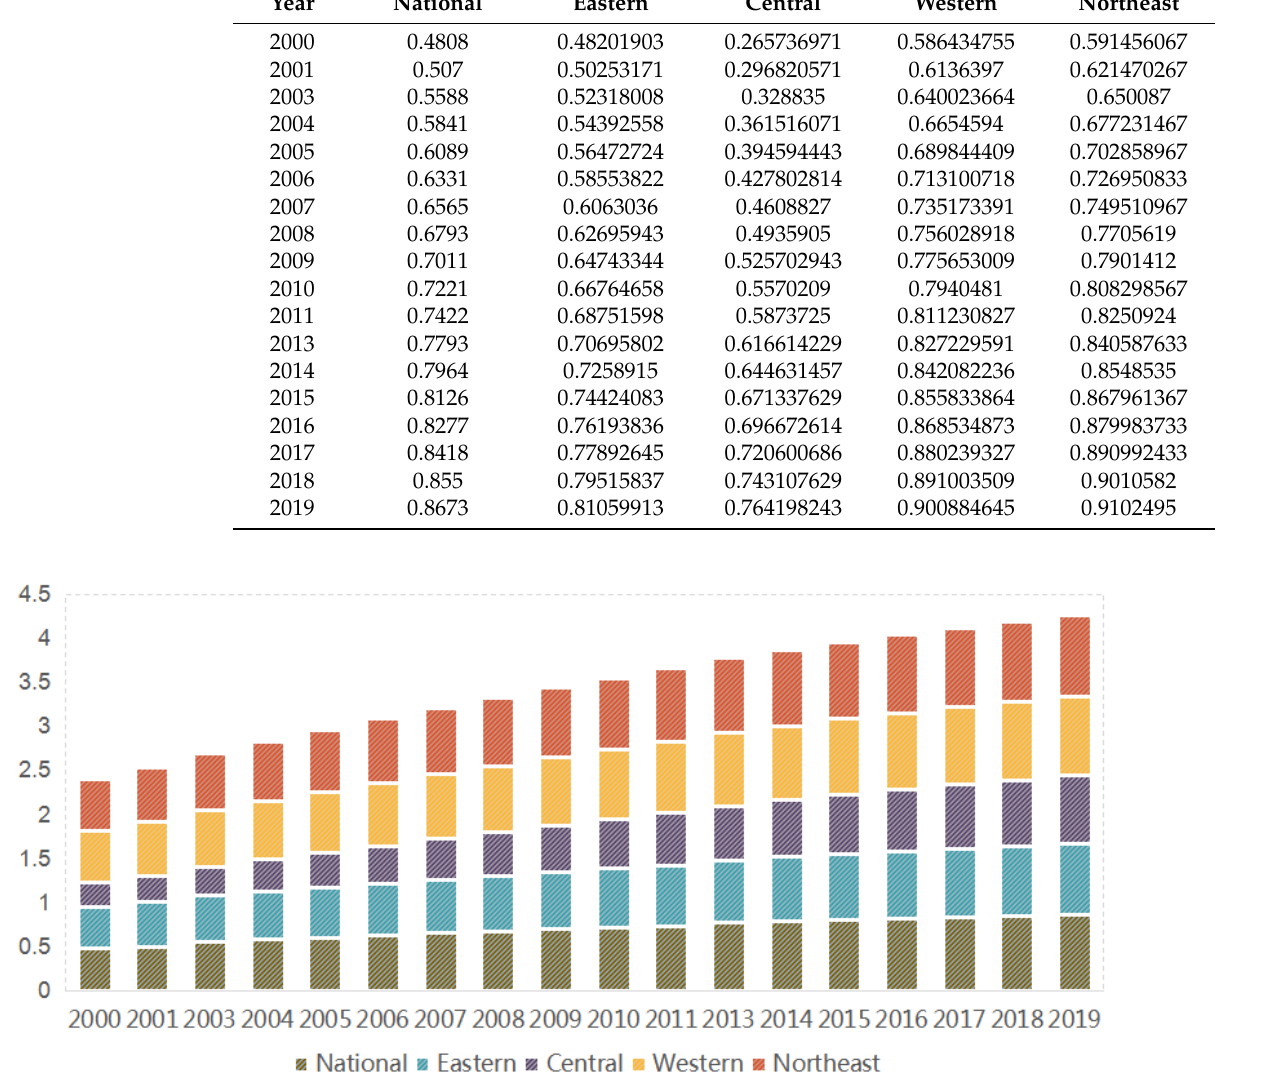
Figure 2. Time-series changes in green production efficiency of